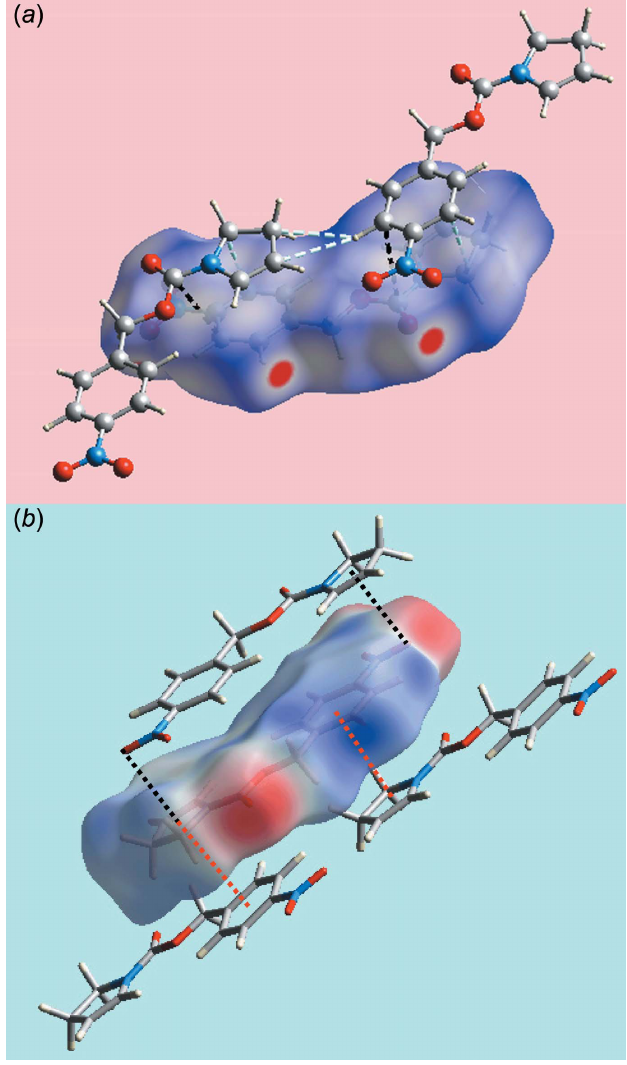
Figure 4 Views of Hirshfeld surfaces for (I) mapped: ( a ) over d norm in the range (cid:5) 0.225 to + 1.393 au, highlighting inter- and intra-layer C (cid:2)(cid:2)(cid:2) C and C (cid:2)(cid:2)(cid:2) H/ H (cid:2)(cid:2)(cid:2) C contacts as black and sky-blue dashed lines, respectively, and ( b ) over the electrostatic potential in the range (cid:6) 0.077 au (the red and blue regions represent negative and positive electrostatic potentials, respec- tively), showing intermolecular N—O (cid:2)(cid:2)(cid:2) (cid:2) and (cid:2) – (cid:2) contacts as black dotted